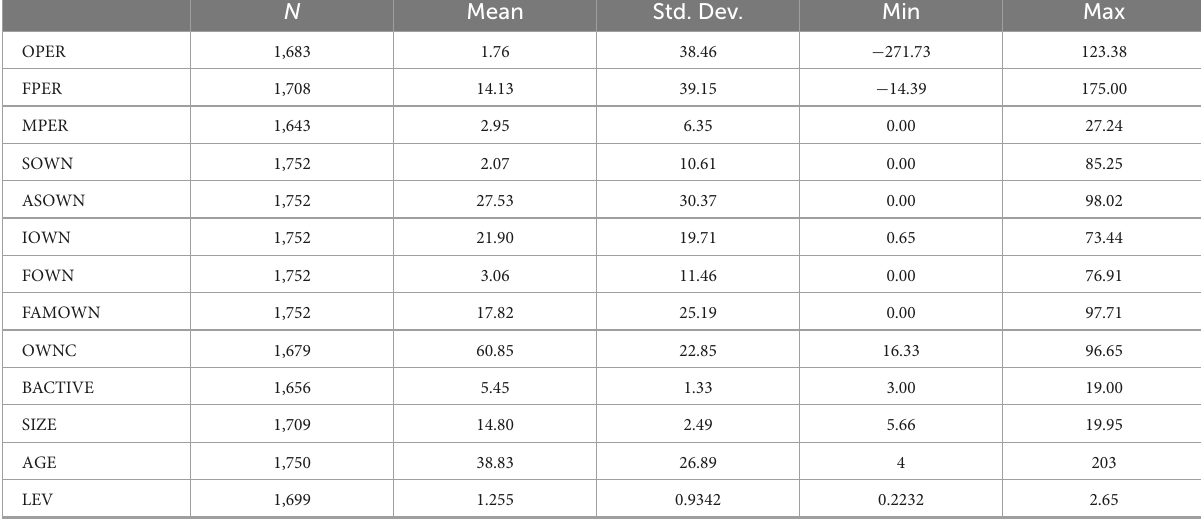
TABLE 2 Summary statistics.